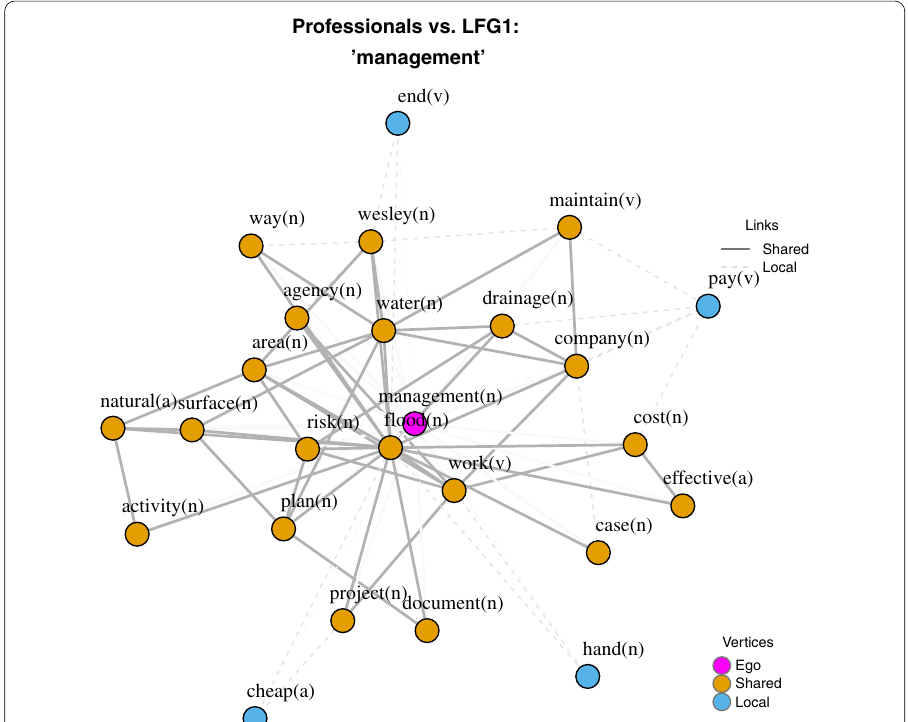
Fig. 16 Top 50 most connected concepts for the total local network of LFG1. The concept of “management” yields the highest vertex and link